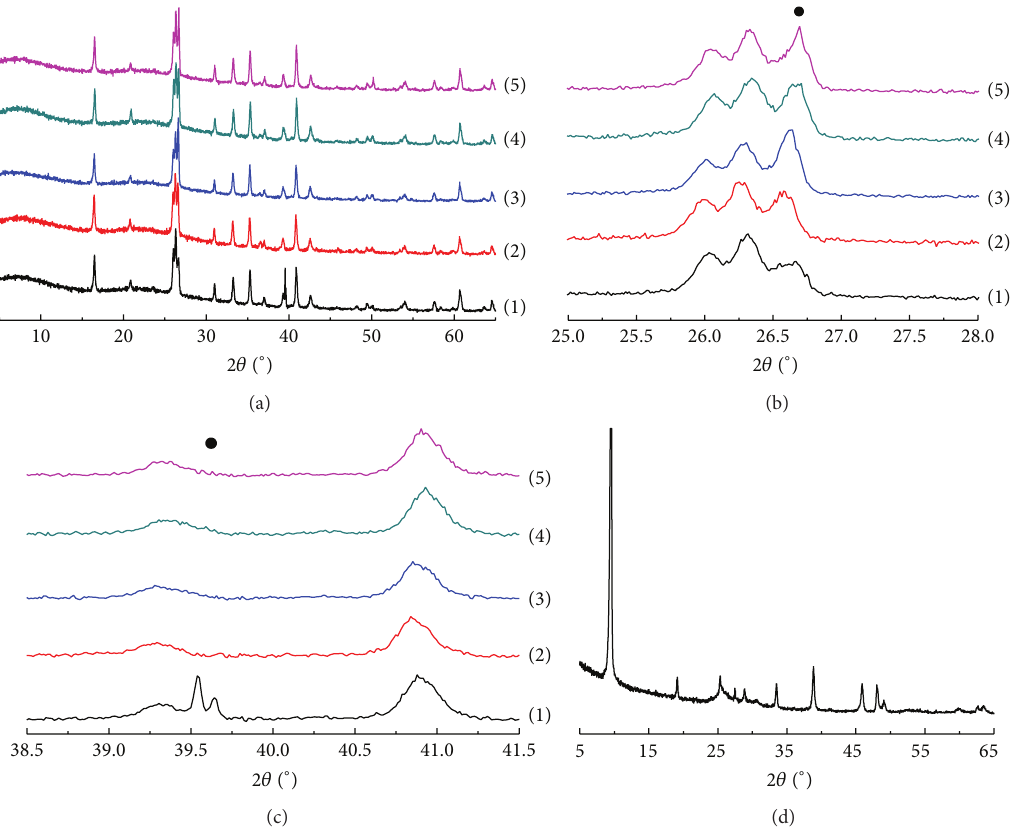
Figure 4: XRD patterns of (a–c) CFA and Ti 0.91 O 2 /CFA samples and (d) protonic titanate: (1) CFA; (2) Ti 0.91 O 2 /CFA-2; (3) Ti 0.91 O 2 /CFA-4; (4) Ti 0.91 O 2 /CFA-6; (5) Ti 0.91 O 2 /CFA-8.